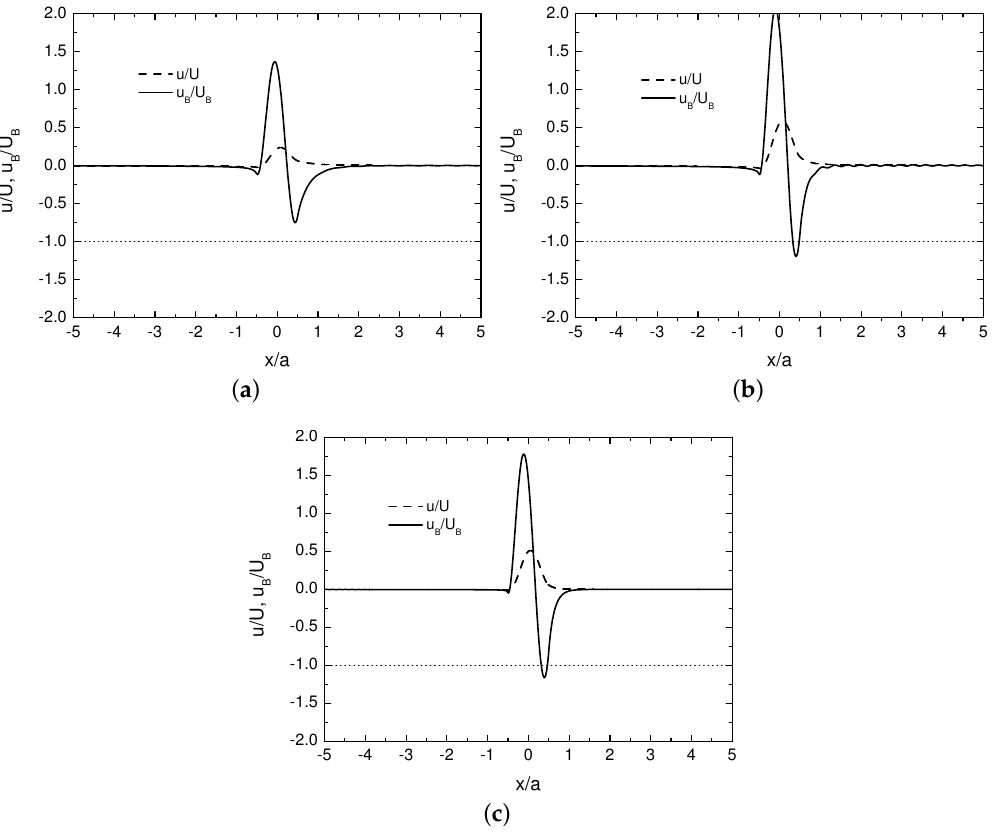
Figure 2. Velocity perturbation normalized by the mean velocity outside ( u / U ) and inside ( u B / U B ) the surface layer (see legend), as a function of downstream distance from the orography (assumed to be centred at x = 0) normalized by its width, calculated from the full model for l 2 a = 12.5. Horizontal dotted line: flow stagnation threshold. ( a ) Fr = 0.6, ( l 2 H ) − 1 = 0.5; ( b ) Fr = 0.6, ( l 2 H ) − 1 = 1; ( c ) Fr = 0.4, ( l 2 H ) − 1 =